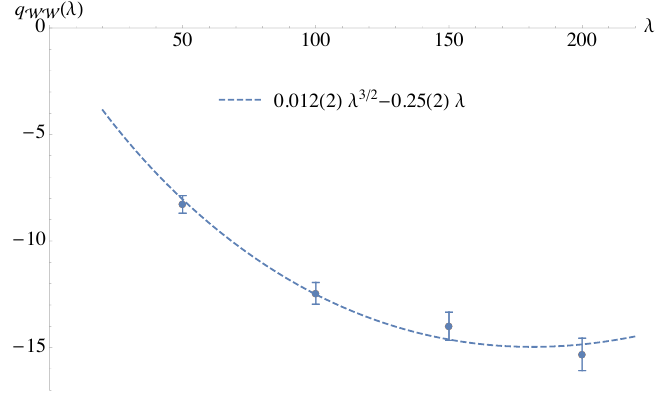
Figure 6 . Data for the q ( λ ) function in (6.4) controlling the 1 /N 2 correction to h W 1 W 2 i in the WW orbifold